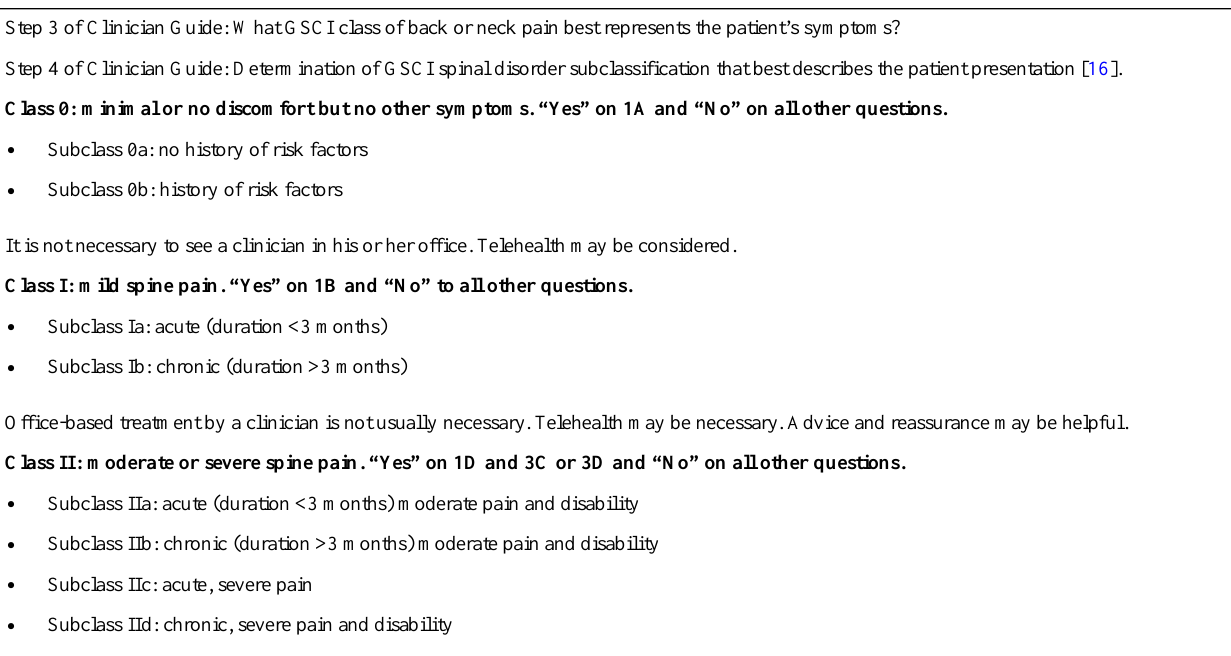
Textbox 3. Steps 3 and 4 of Clinician